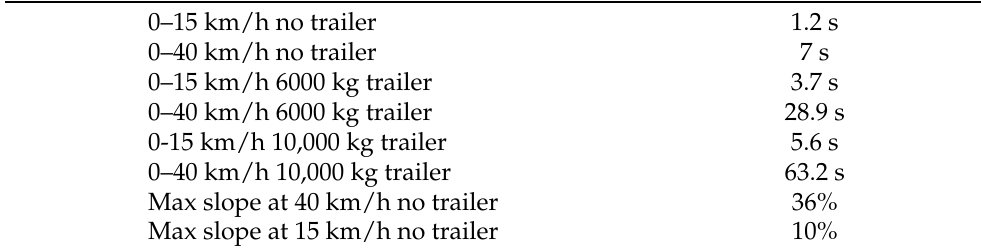
Table 9. HeCVT performance in full electric mode.